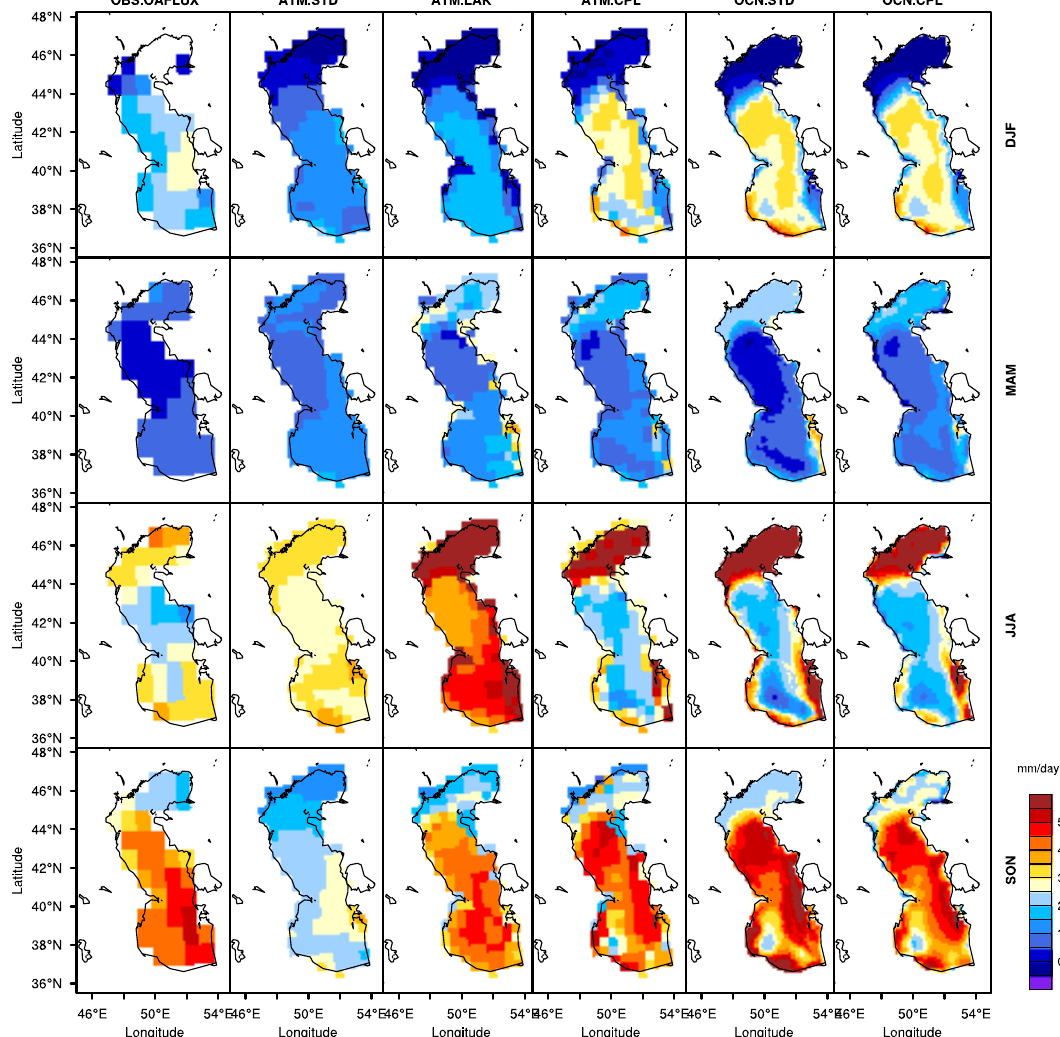
Fig. 13. Seasonal sea surface evaporation climatology of simulations and observation (Objectively Analysed air-sea Fluxes OAFlux for Global Oceans) for the period